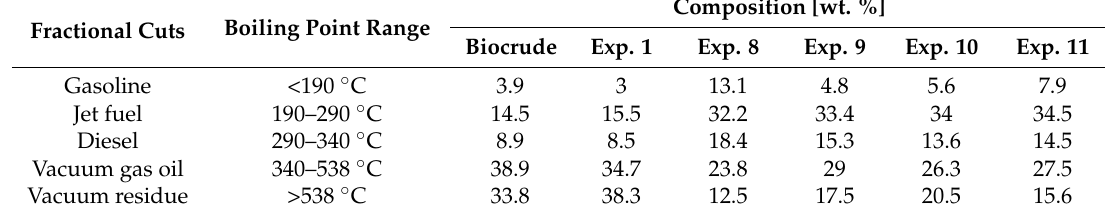
Table 6. Sim-Dis analysis of biocrude and selected hydrotreated samples.